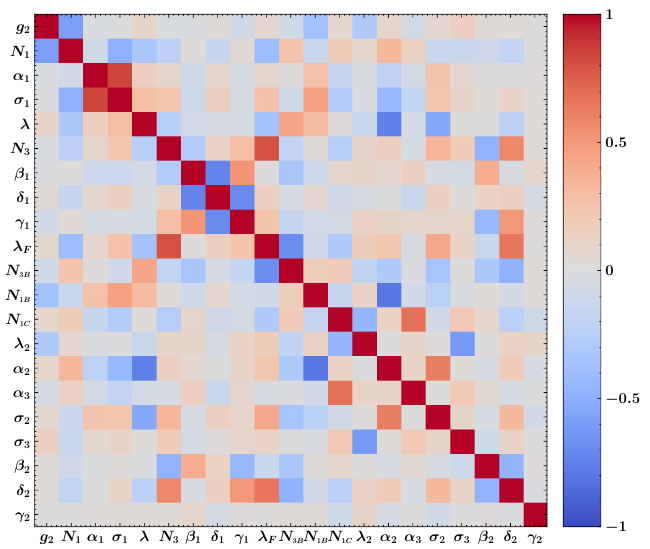
Figure 12 . Graphical representation of the correlation matrix for the fitted parameters.